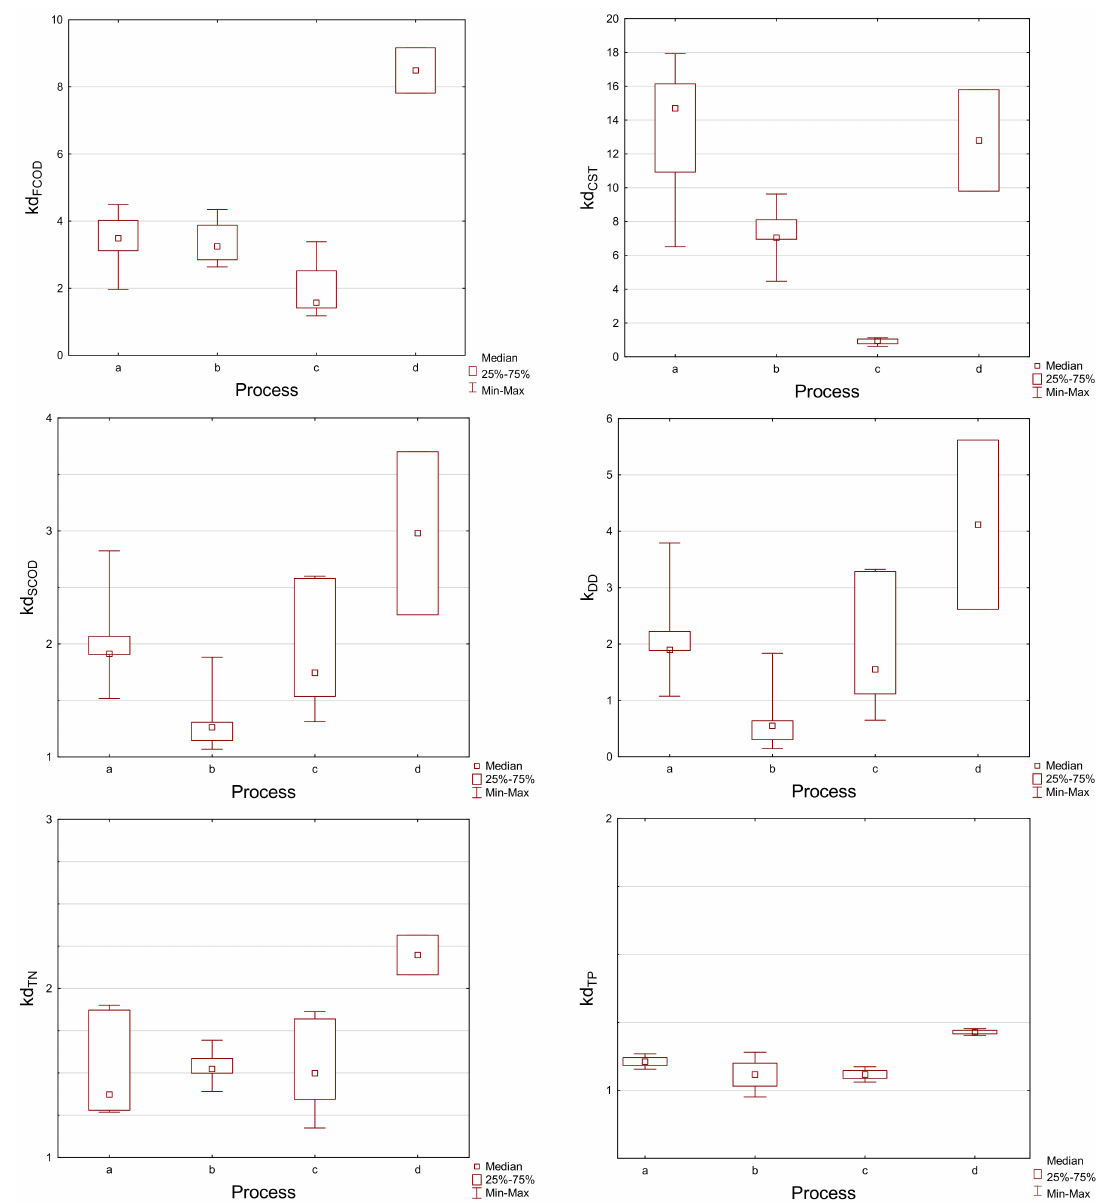
Figure 4. Box plot of kd indicators in relation to the disintegrator type p < 0.05. Disintegrator